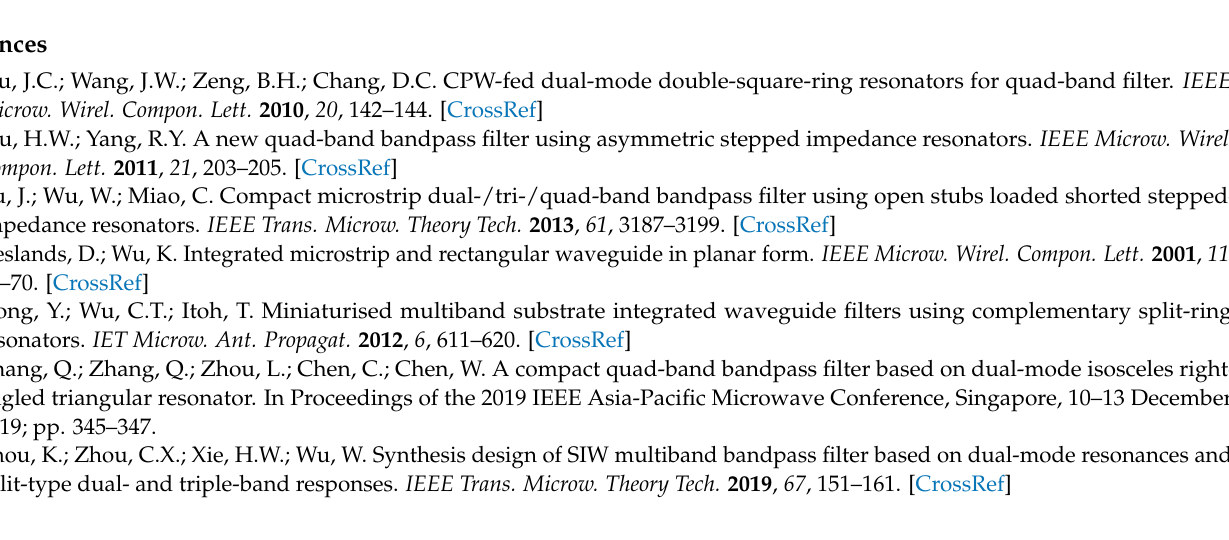
tom layer (attached by an SMA). layer (attached by an